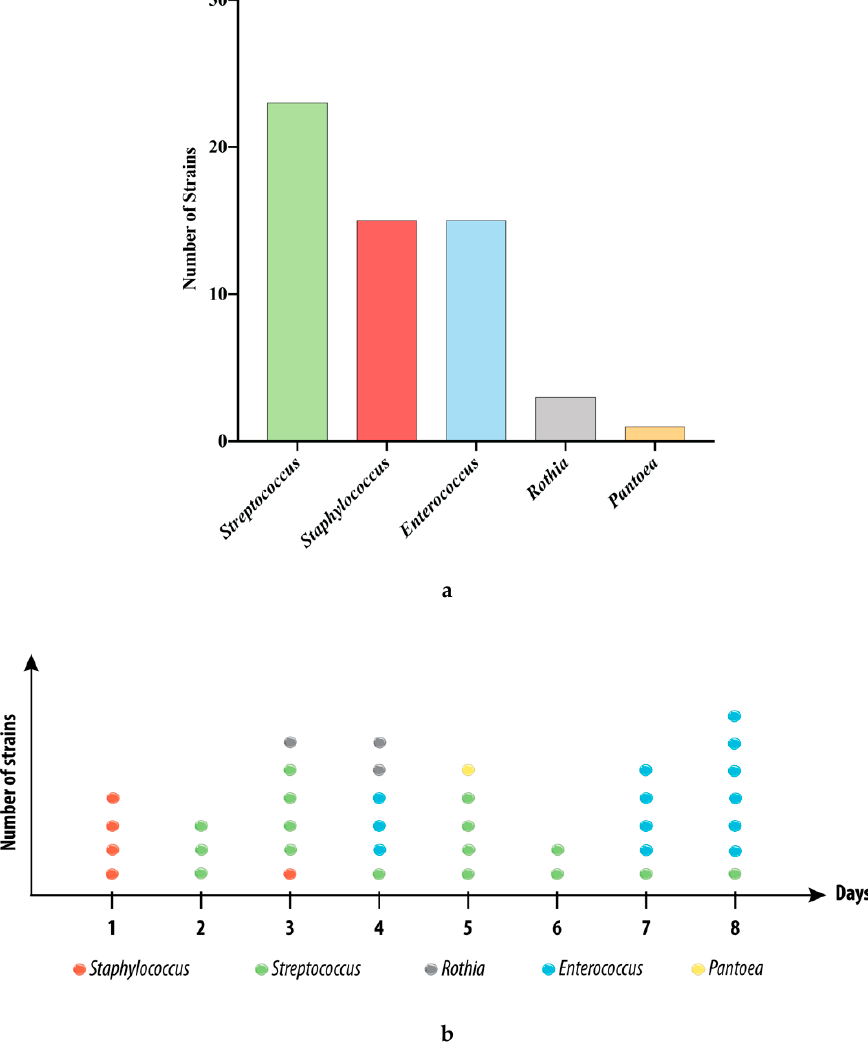
Figure 1. The bacterial library contains members of the early life buccal core microbiota. ( a ) Genera repartition of the 57 strains identified in all the samples (days are mixed) from both donors. ( b ) Bacterial distribution through the days for one donor ( n = 38). Strains were identified at the genus level, using 16S PCR sequencing. Data are presented as the number of strains per genera. Each dot represents a strain.